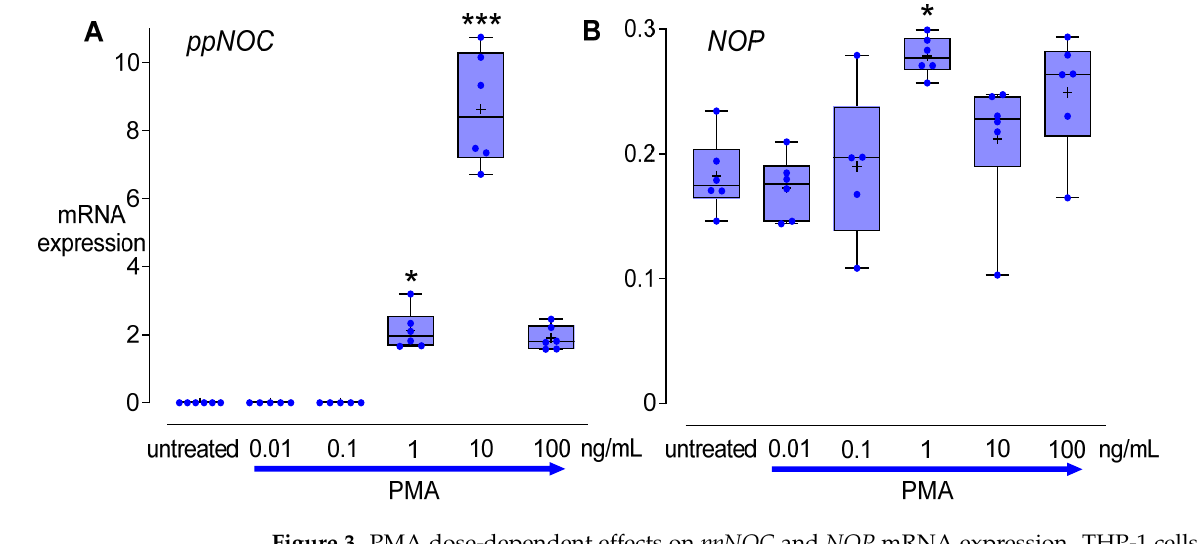
Figure 3. PMA dose-dependent effects on ppNOC and NOP mRNA expression. THP-1 cells were cultured with different concentrations of PMA (0.01–100 ng/mL) or without PMA (control) for 24 h. mRNA levels of ppNOC ( A ) and NOP ( B ) were determined. Boxplots with individual data points, median, IQR, and mean “+”; n = 6. Kruskal-Wallis test with post hoc test (Dunn’s). *, p < 0.05, ***, p < 0.001, compared to the respective controls (untreated).